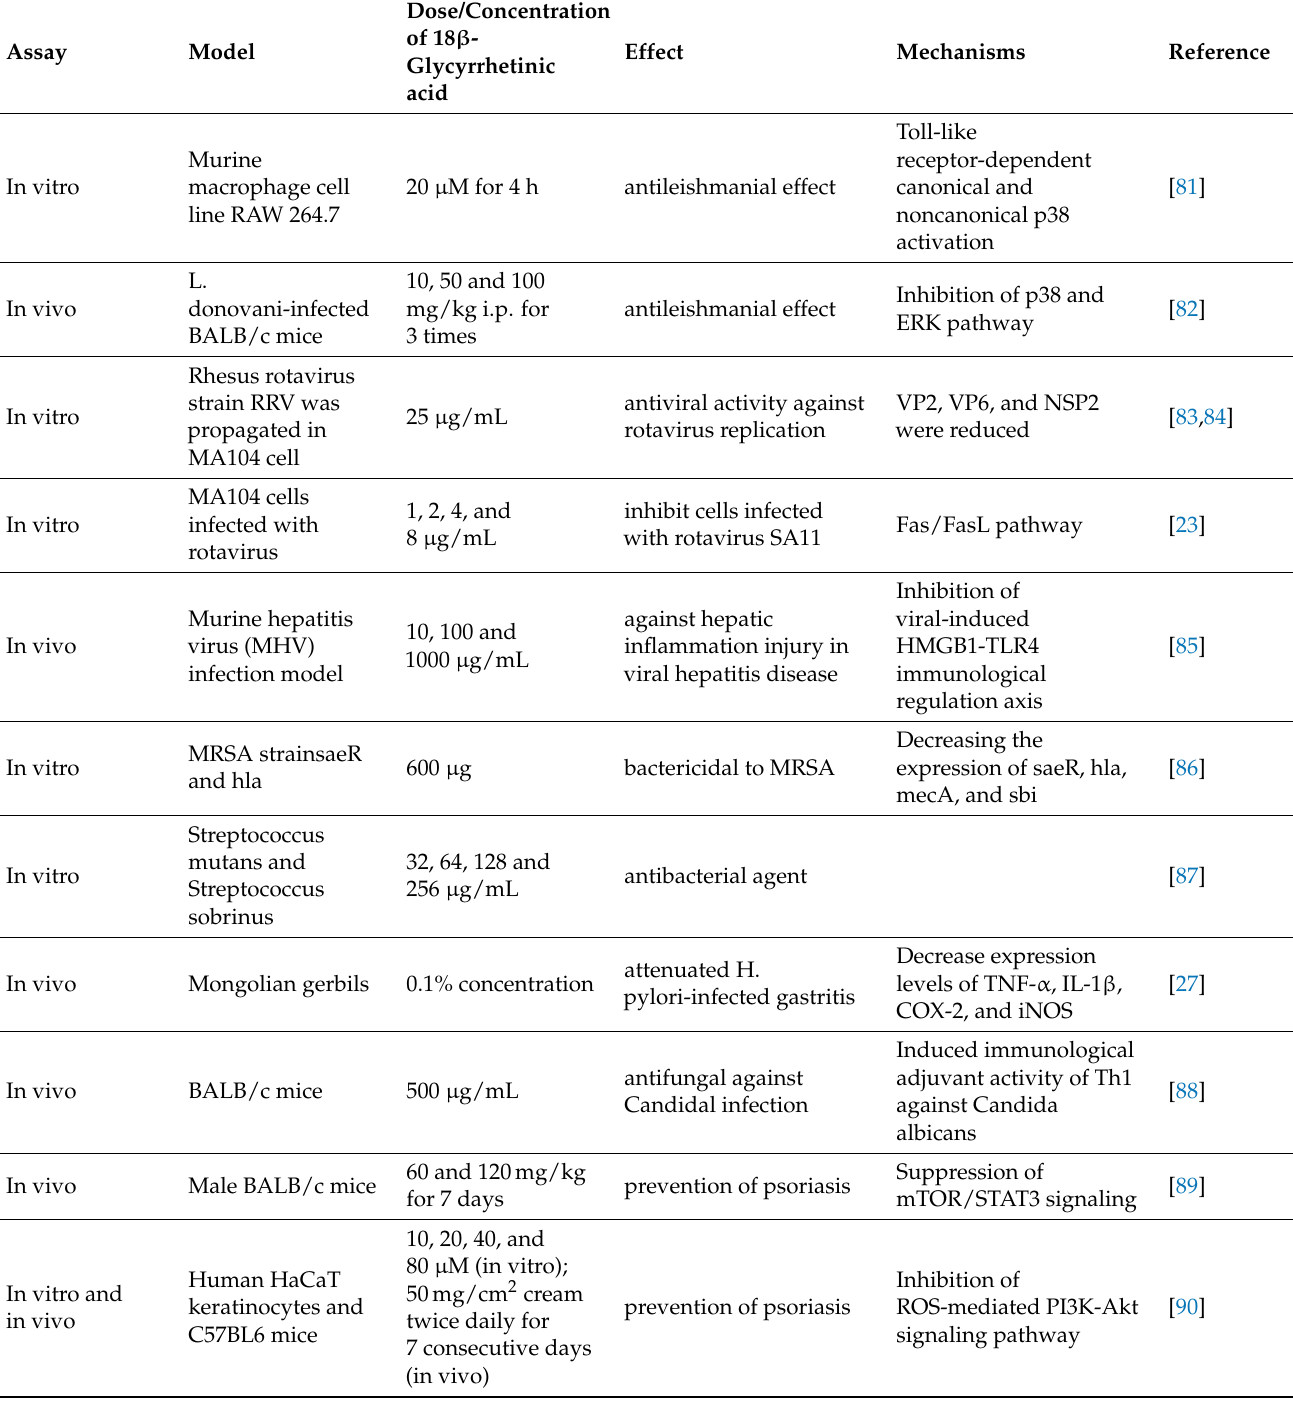
Table 3. Antileishmanial, antiviral, antibacterial, antifungal, and prevention of psoriasis and mecha- nisms of 18 β -glycyrrhetinic acid in in vitro and in